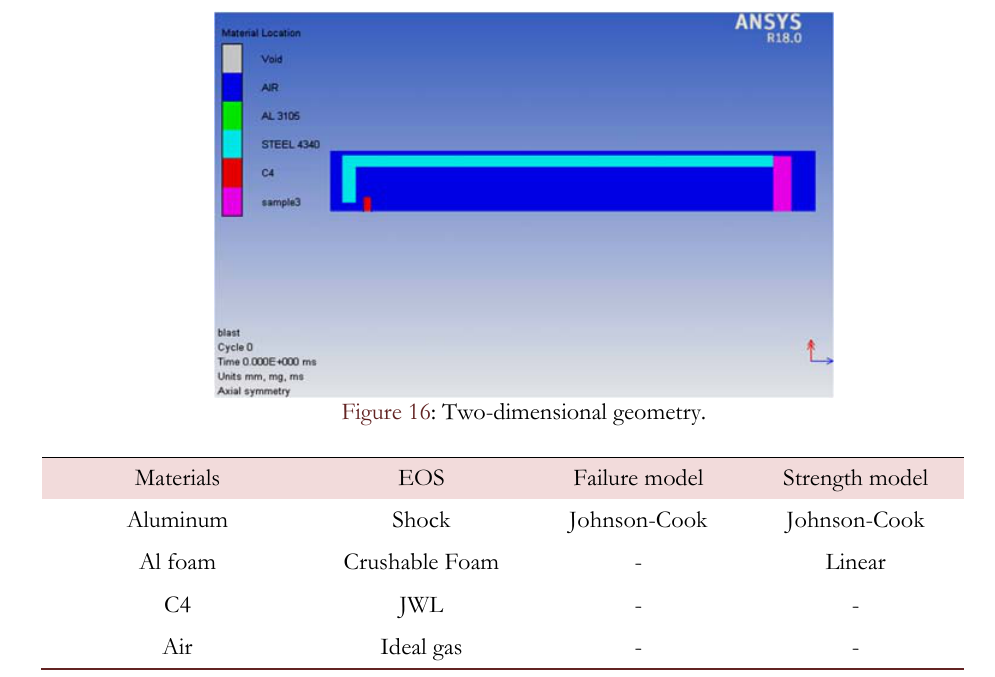
Table 3: Equations used in modeling.